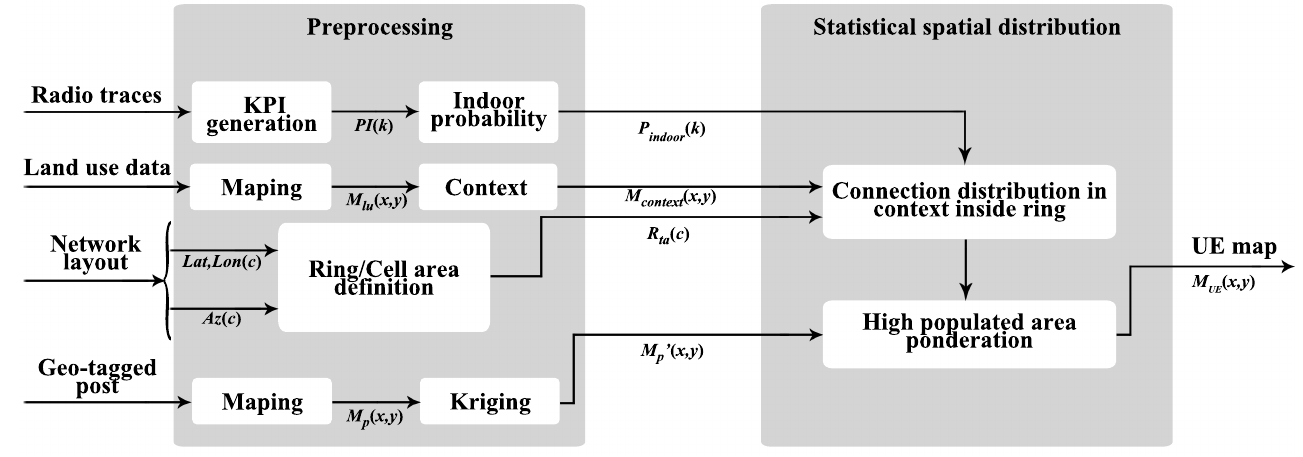
Figure 1. Flow diagram of the spatial distribution